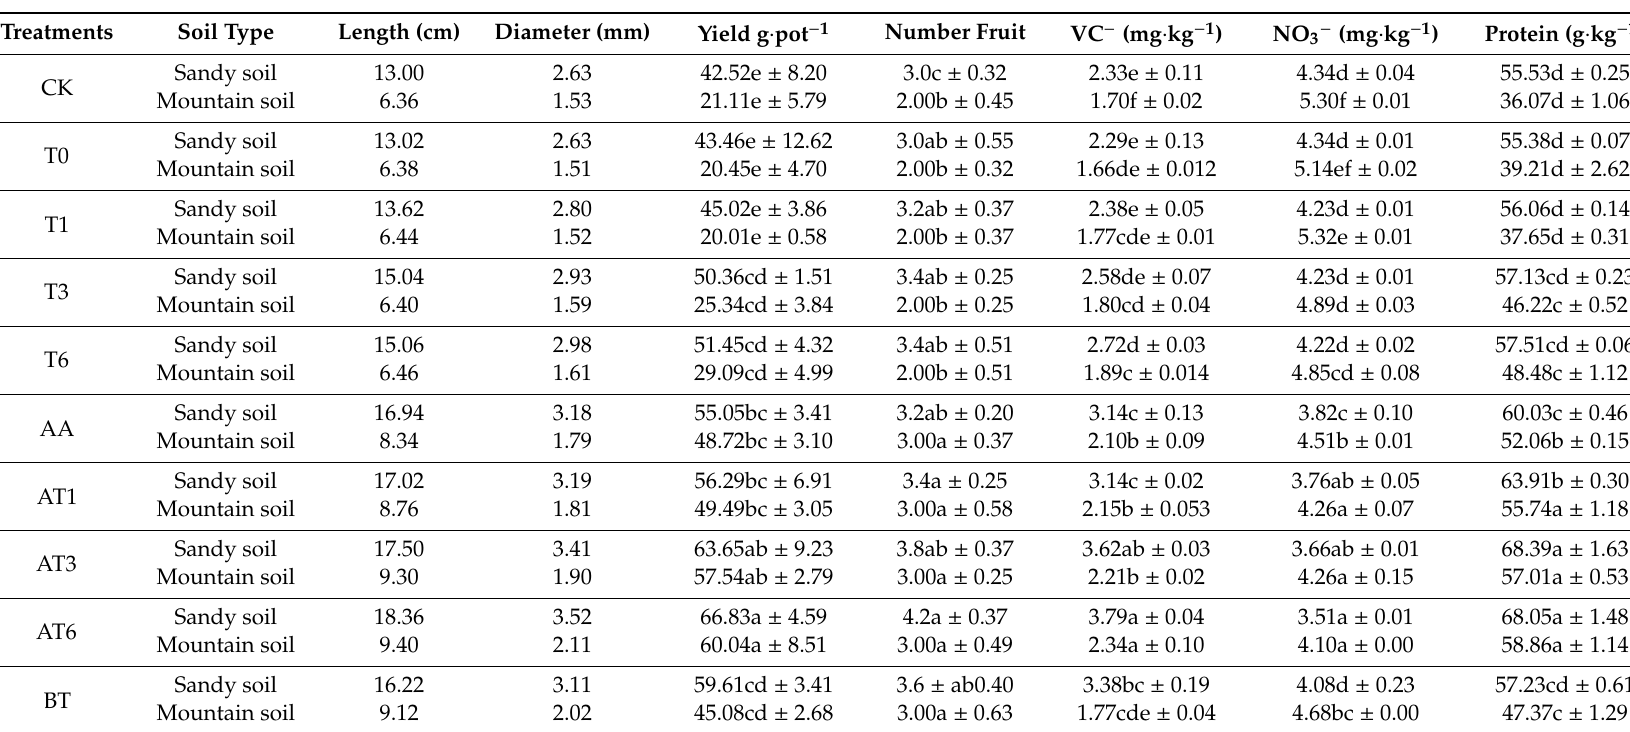
Table 1. The growth-related traits (shoot height, stem diameter), fruit yield and quality of first season peppers with di ff erent treatments in two kinds of soils.